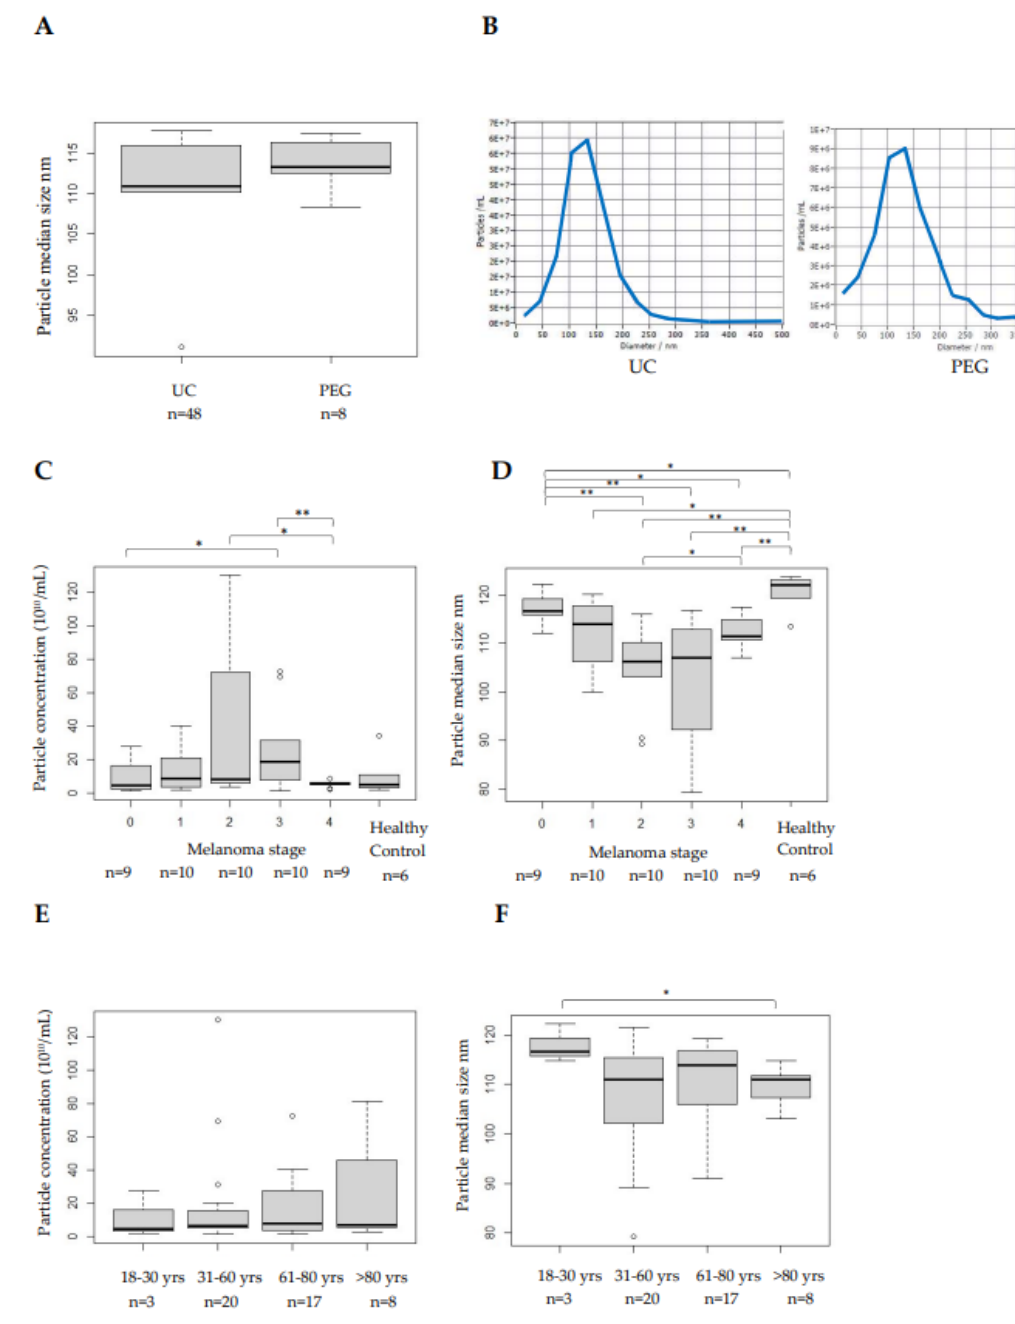
Figure 1. Biophysical characterization of EVs. ( A ) The particle median size measured by nanotracking analysis (NTA) for both ultracentrifugation (UC) and polymer precipitation (PEG) samples. ( B ) The profiles of EVs obtained with NTA. ( C ) Particle concentration measured by NTA in UC purified samples grouped by melanoma stages. ( D ) Particle median size measured by NTA in UC purified samples grouped by melanoma stages. ( E ) The particle concentration measured by NTA in UC purified samples grouped by age. ( F ) Particle median size measured by NTA in UC purified samples grouped by age. N—number of patients analyzed. The results indicated with * have a statistically significant difference compared to the value of the PBS-treated sample: * p -value < 0.05; ** p -value < 0.01.